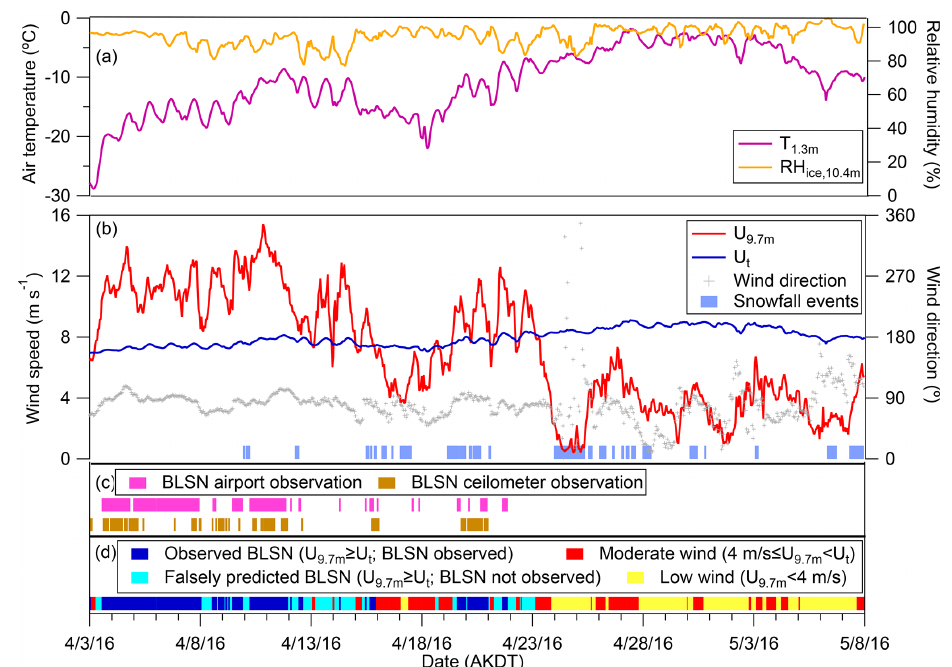
Figure 2. Time series of (a) air temperature at 1.3m ( T 1 . 3m ), relative humidity with respect to ice at 10.4m (RH ice , 10 . 4m ), (b) wind speed ( U 9 . 7m ) and wind direction at 9.7m, calculated blowing snow threshold wind speed ( U t ), and snowfall events recorded by the Utqia˙gvik, Alaska, airport, (c) observations of BLSN at the airport and from the DOE ARM Observatory ceilometer measurements, and (d) observed BLSN ( U 9 . 7m ≥ U t and BLSN observed by either the airport or ceilometer), falsely predicted BLSN ( U 9 . 7m ≥ U t and BLSN not observed by the airport or ceilometer), moderate wind speed (4ms − 1 ≤ U 9 . 7m <U t ), and low wind speed ( U 9 . 7m < 4ms − 1 )